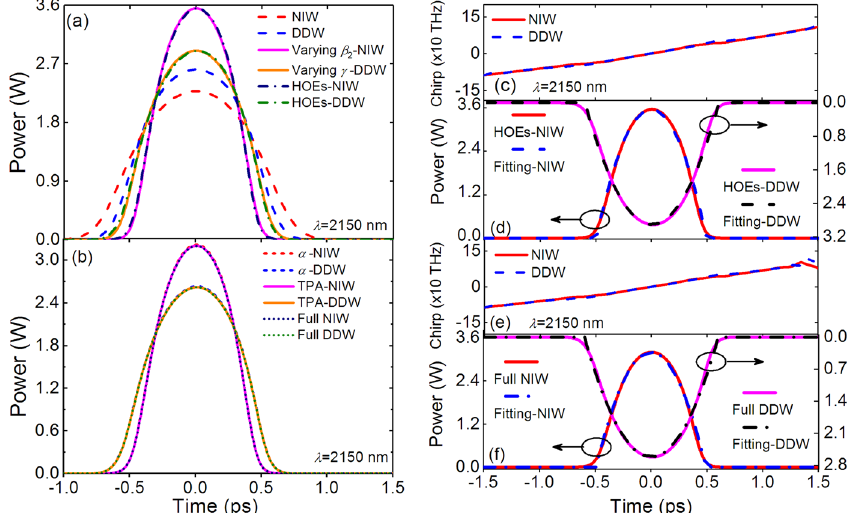
Figure 9. Output pulses with pump wavelength 2150 nm. ( a ) Output pulse waveforms with ideal NIW (red dashed curve), ideal DDW (blue dashed curve), varying β 2 -NIW (magenta solid curve), varying γ -DDW (orange solid curve), HOEs-NIW (navy dash-dotted curve), and HOEs-DDW (olive dot-dashed curve), ( b ) Output pulse waveforms with lossy terms in α -NIW (red short dashed curve), α -DDW (blue short dashed curve), TPA-NIW (magenta solid curve), TPA-DDW (orange solid curve), Full NIW (navy dotted curve) and Full DDW (olive dotted curve). ( c ) Chirp profiles of pulses from HOEs-NIW (red solid curves) and HOEs- DDW (blue dashed curve). ( d ) Output pulses of HOEs-NIW (red solid curve), parabolic fit for NIW (blue dashed curve), HOEs-DDW (magenta solid curve), and parabolic fit for DDW (black dashed curve). ( e ) Chirp profiles of pulses from Full NIW (red solid curve) and Full DDW (blue dashed curve). ( f ) Output pulses of Full NIW (red solid curve), parabolic fit for NIW (blue dot-dashed curve), Full DDW (magenta solid curve), and parabolic fit for DDW (black dot-dashed